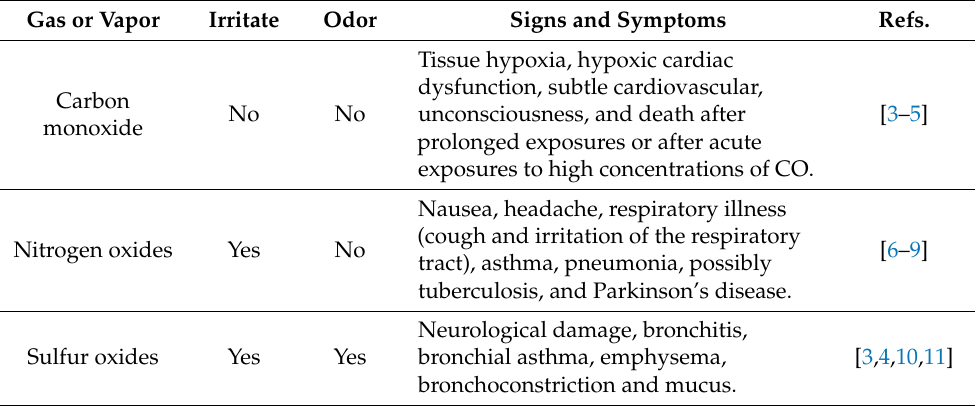
Table 1. Main toxic inhalation hazards.